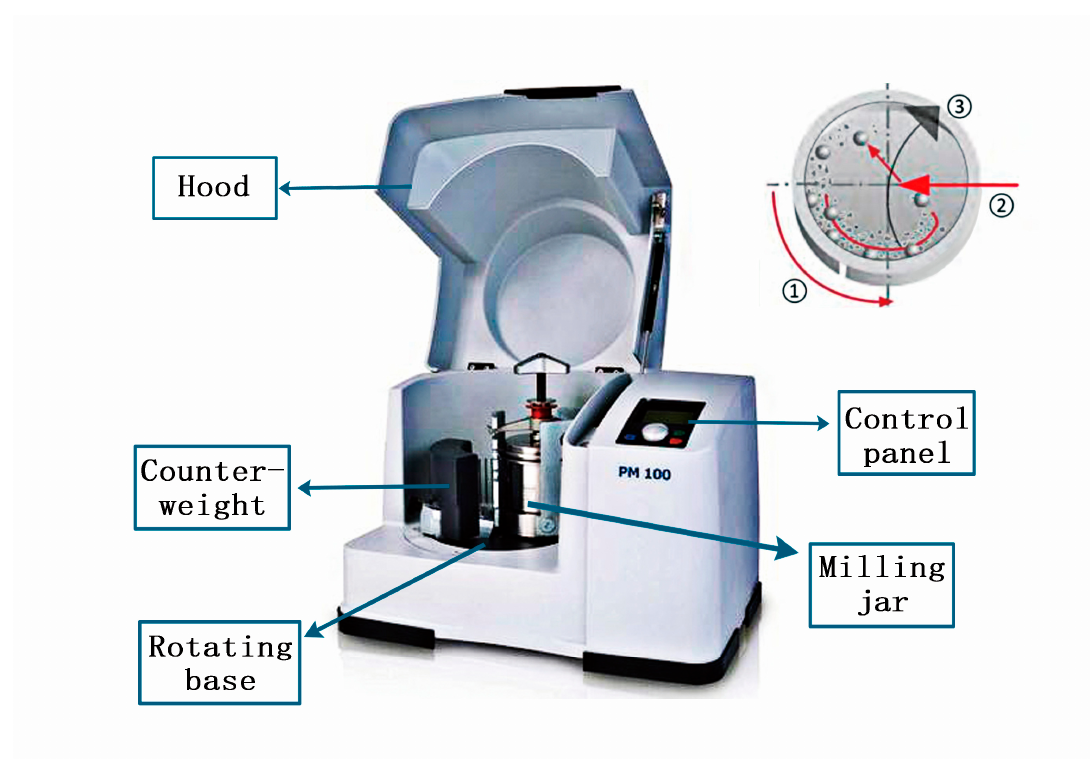
Figure 1. The set-up of the planetary ball mill.